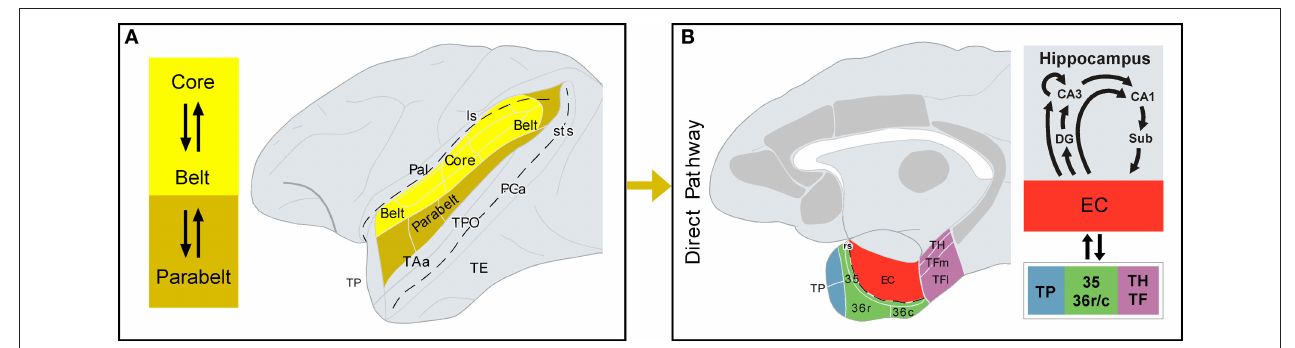
shown in a medial view of the primate brain. Additional cortical areas that receive auditory input and project to the parahippocampal region are shown in gray, but they form part of the indirect pathway (see Figure 3 for further details). Connections between the parahippocampal region and the hippocampal formation are summarized on the right-hand side. See list of abbreviations.